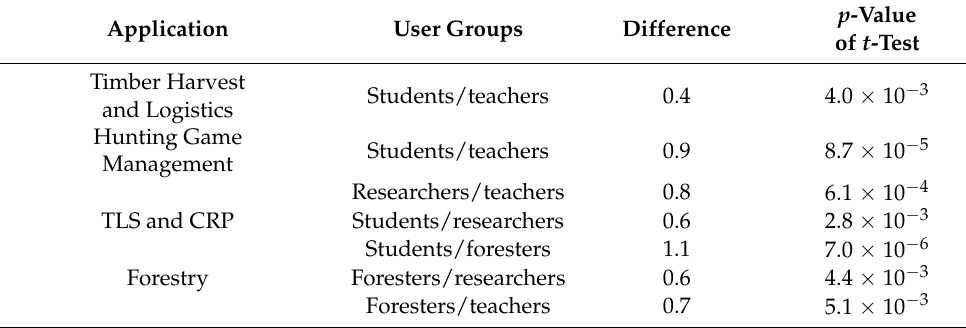
Table A4. Significant differences in web mapping application scores by user group.